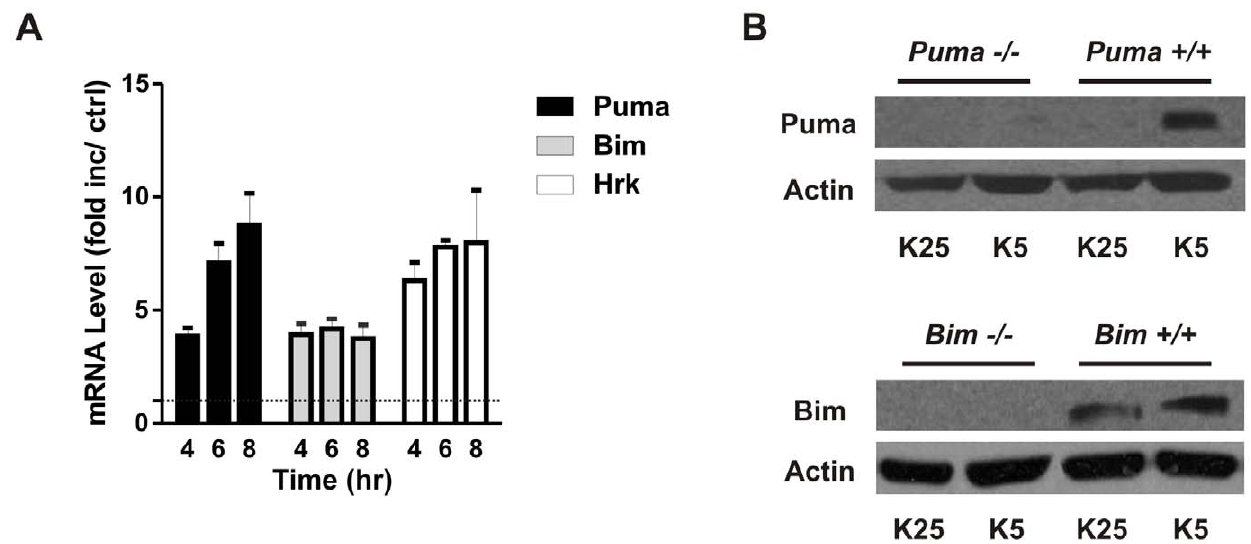
Figure 1. Puma expression is induced by potassium withdrawal in cerebellar granule neurons. After 7 days in culture CGNs were either maintained in media containing 25 mM potassium (K25) or switched to low potassium medium containing 5 mM potassium (K5). A, RNA was harvested after 4, 6 and 8 hours and Puma, Bim and Hrk expression was analyzed by qRT-PCR. Expression was normalized to ribosomal S12 levels and is reported as fold increase over untreated controls (n=4, p , 0.05). B, Protein extracts were collected from CGNs derived from Puma + / + and Puma 2 / 2 littermates or Bim + / + and Bim 2 / 2 littermates 8 hours after potassium withdrawal and Puma and Bim protein levels were analyzed by western blot. Actin was included as a loading